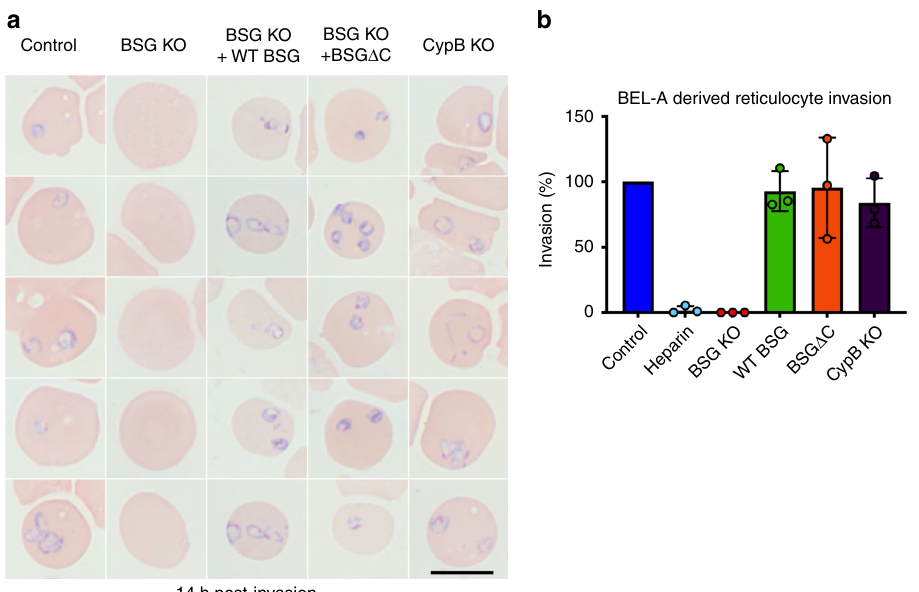
Fig. 5 Basigin-dependent Plasmodium falciparum invasion of reticulocytes can be ablated and complemented through genetic manipulation of BEL-A cells. a Rings are completely absent in reticulocytes derived from BSG KO BEL-A cells but are observed in reticulocytes derived from WT BSG and BSG Δ C rescue lines and from a CypB KO. Black scale bar shown at bottom right is 10 µ m. b Bar graph illustrating quanti fi cation of invasion of reticulocytes derived from indicated lines. Data represent invasion ef fi ciency normalized to invasion in unedited control BEL-A-derived reticulocytes and assessed through blinded manual counting of Giemsa-stained cytospins from three independent experiments ( n = 3). Error bars represent standard deviation of the mean, and individual data points are represented as fi lled circles. A one sample t test showed no signi fi cant difference in invasion into control BEL-A cells compared with invasion into WT BSG rescue, BSG Δ C rescue, and CypB KO lines. Assays in which heparin is used to inhibit invasion provide a negative